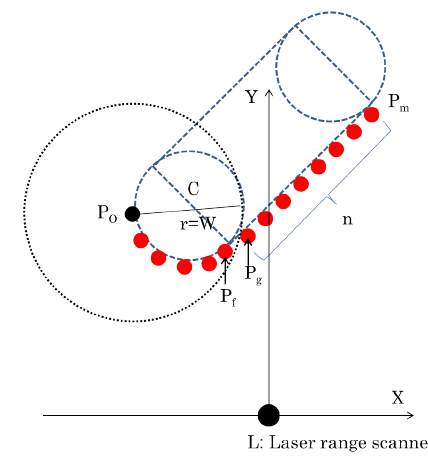
Fig. 10. How to Distinguish a "Fuzzy"